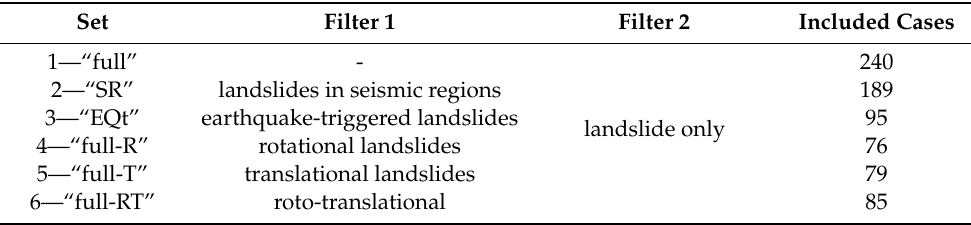
Table 2. Subsets of the database used for analyses with their respective first and second filters. Set Filter 1 Filter